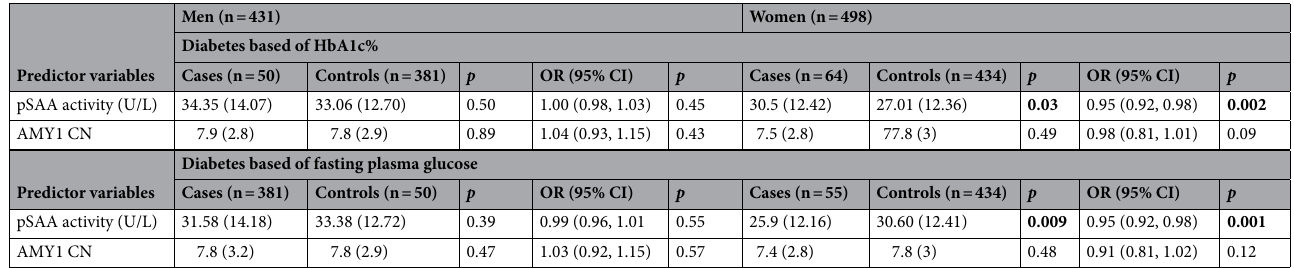
Table 2. Association between pSAA activity or AMY1 CN and the odds of having diabetes in men and women. pSAA activity and AMY CNV values are means and (SD). The table includes the logistic regression analysis adjusted for age and BMI. Cases are the individuals with diabetes (based on HbA1c or FPG), while controls are the individuals without diabetes. The significant p values are shown in